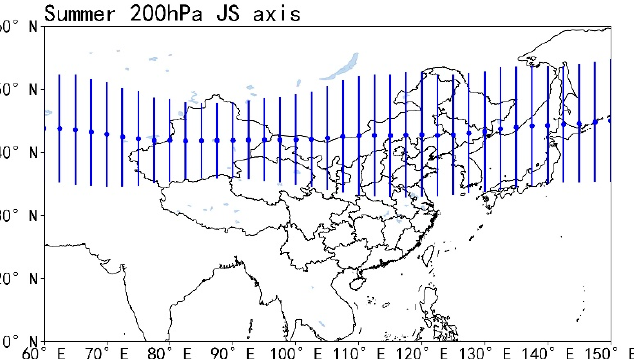
Figure 1. The average climate state of the jet stream axis at 200 hPa in summer from 1989 to 2018 (scatter points and error bars indicate the average position and the variabilities of the jet stream axis, respectively).